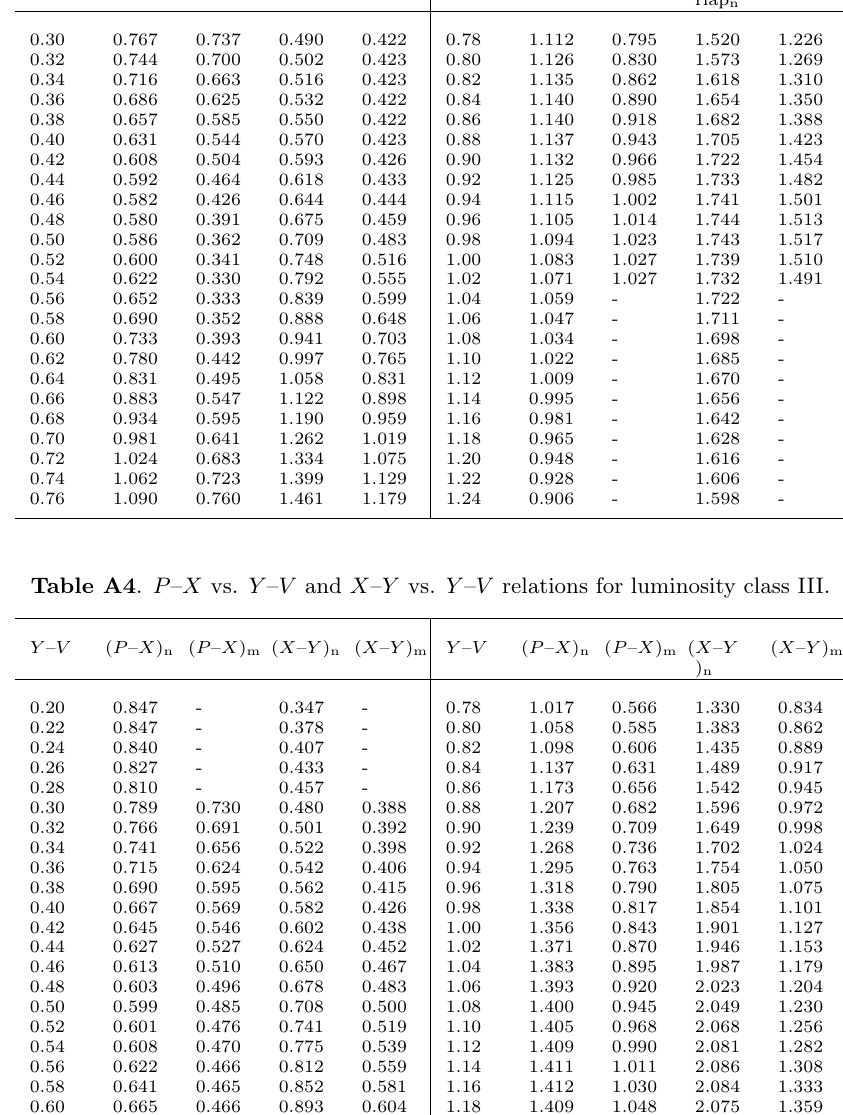
Table A3 . P – X vs. Y – V and X – Y vs. Y – V relations for luminosity class V. Y { V